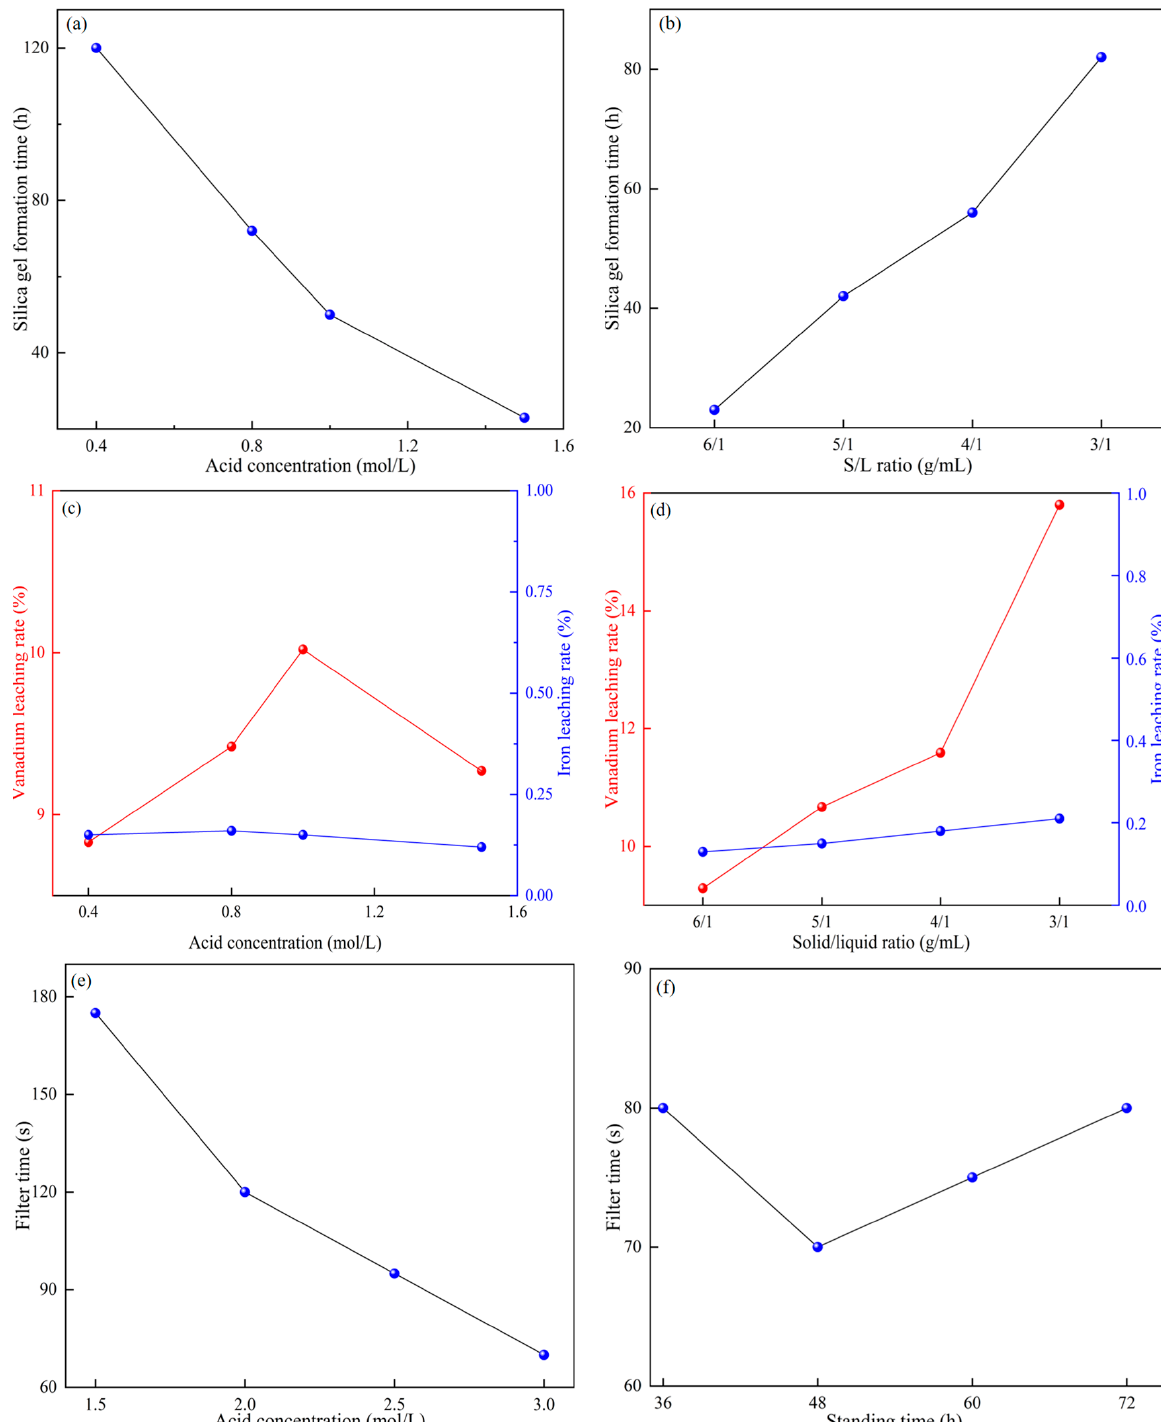
Figure 3. Effects of ( a , c ) acid concentration, ( b , d ) solid–liquid ratio on the formation time of silica gel and leaching rate of vanadium and iron. Effects of ( e ) acid concentration and ( f ) standing time on filter time of leaching solution.